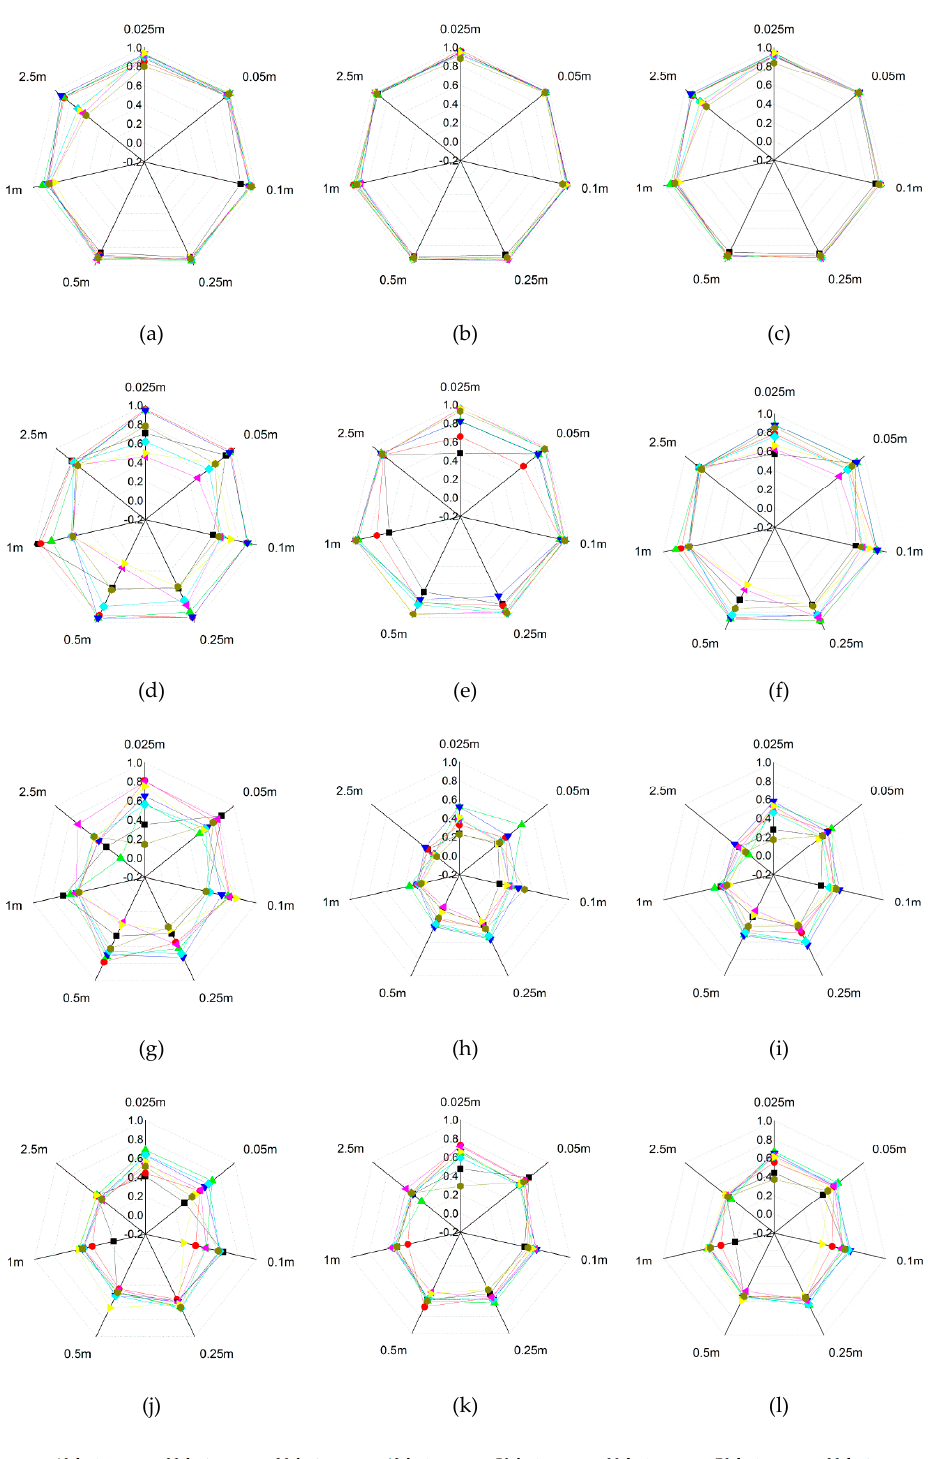
Figure 10. Identification accuracy variation of various vegetation types with image scales and feature numbers; ( a ) producer’s accuracy (PA) of sugarcane; ( b ) user’s accuracy (UA) of sugarcane; ( c ) F-Score of sugarcane; ( d ) PA of eucalyptus; ( e ) UA of eucalyptus; ( f ) F-Score of eucalyptus; ( g ) PA of citrus; ( h ) UA of citrus; ( i ) F-Score of citrus; ( j ) PA of other vegetation; ( k ) UA of other vegetation; ( l ) F-Score of other